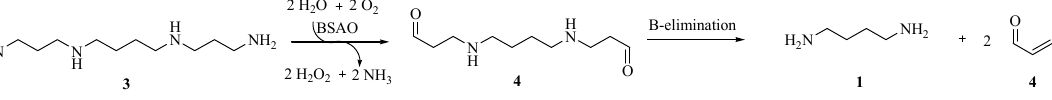
Figure 1. Chemical structures of polyamines 1 – 3 at physiological pH.